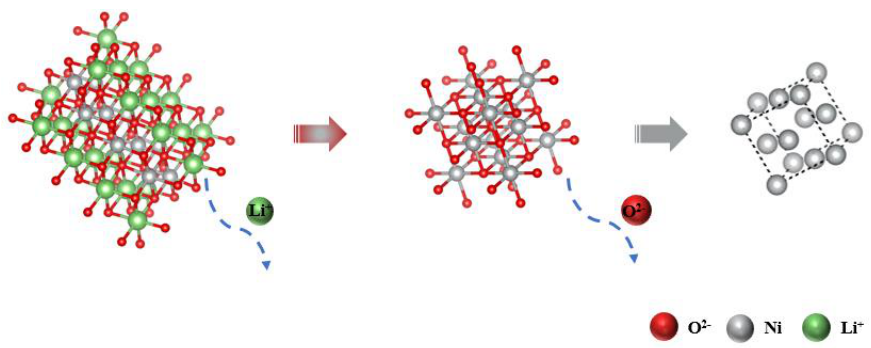
Figure 16. LiNiO 2 atomic structure change during electrolysis.